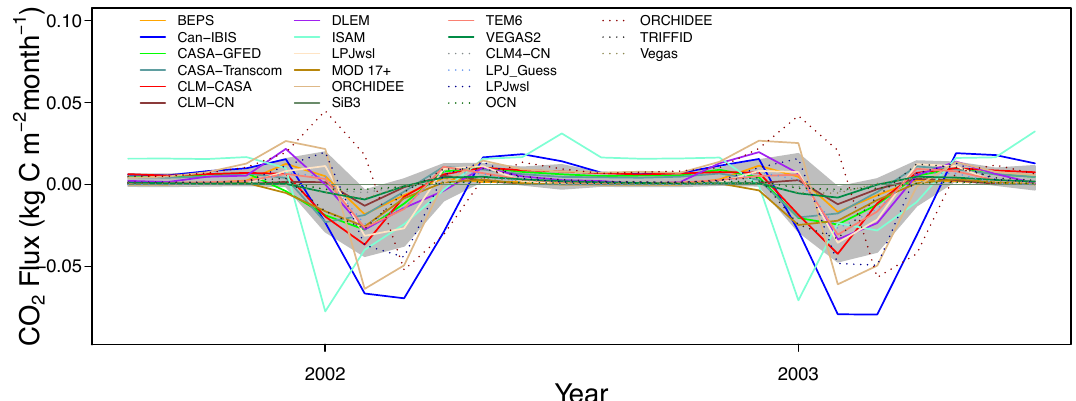
Figure 7. Mean monthly net CO 2 flux for the Alaskan Arctic (North Slope), showing two years for example (2002–2003). NACP models are shown as solid lines, and TRENDY models as dashed lines. The gray area is the multi-model standard deviation. 960 patterns because of our data-removal rule of matching mod- els to data (see Sect.